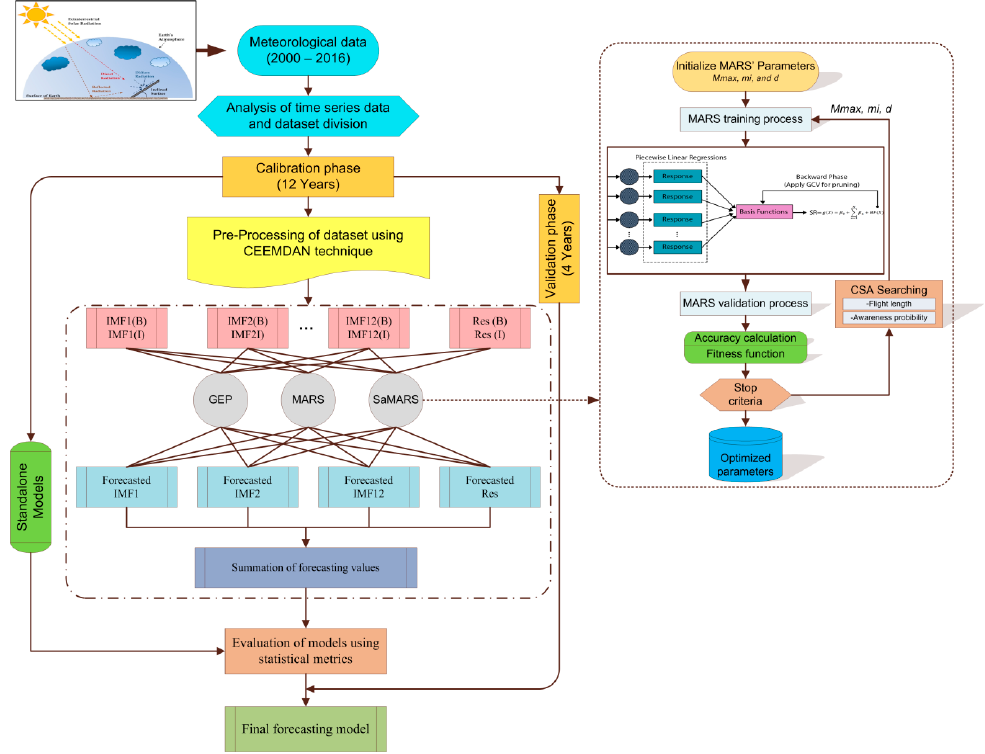
Figure 3. The main procedures of proposed standalone and hybrid models.